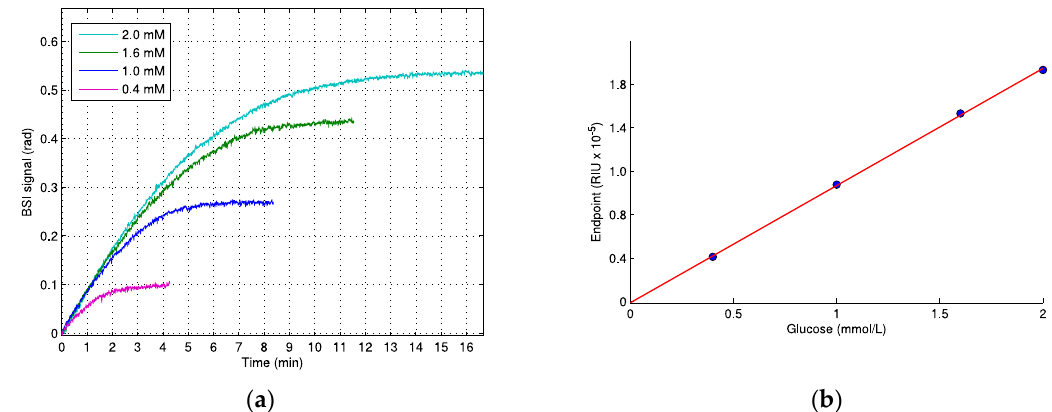
Figure 1. The enzymatic phosphorylation of glucose to glucose-6-phosphate by hexokinase, measured using BSI. ( a ) The real-time measurement of four glucose solutions (0.4, 1.0, 1.6 and 2.0 mM). ( b ) The end-point values in refractive index units vs. initial glucose concentration. Linear fit ( R 2 > 0.99, slope 0.99 × 10 − 5 RIU/mM). Figure 1a is reproduced from reference [8] with permission from Elsevier.